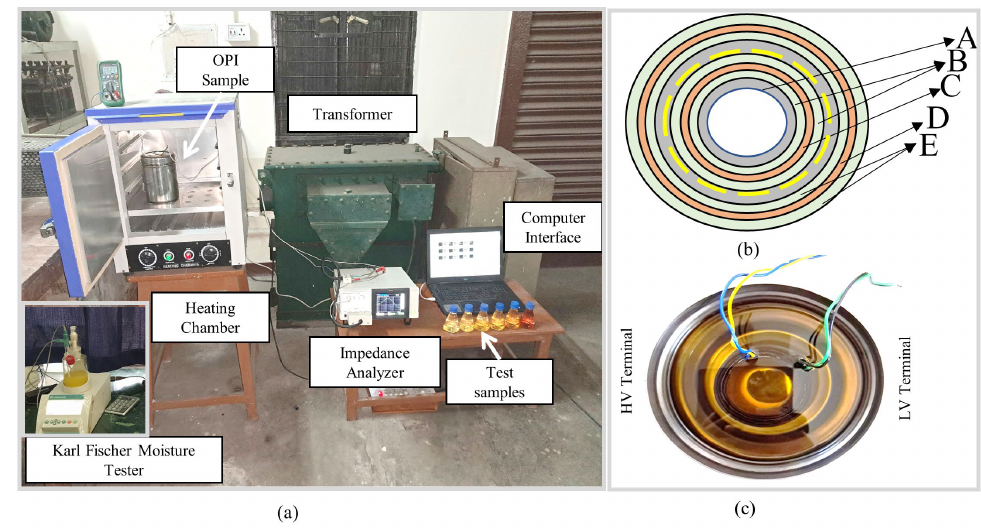
Figure 3. ( a ) Laboratory DFDS test setup with insulation sample and test oil samples, ( b ) Schematic view of the test sample, ( c ) Prepared sample.